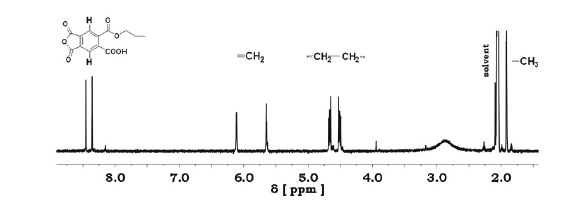
Figure 5: 1H NMR spectrum of PMMAn. Table 4: Composition of the experimental desensitizing formulation